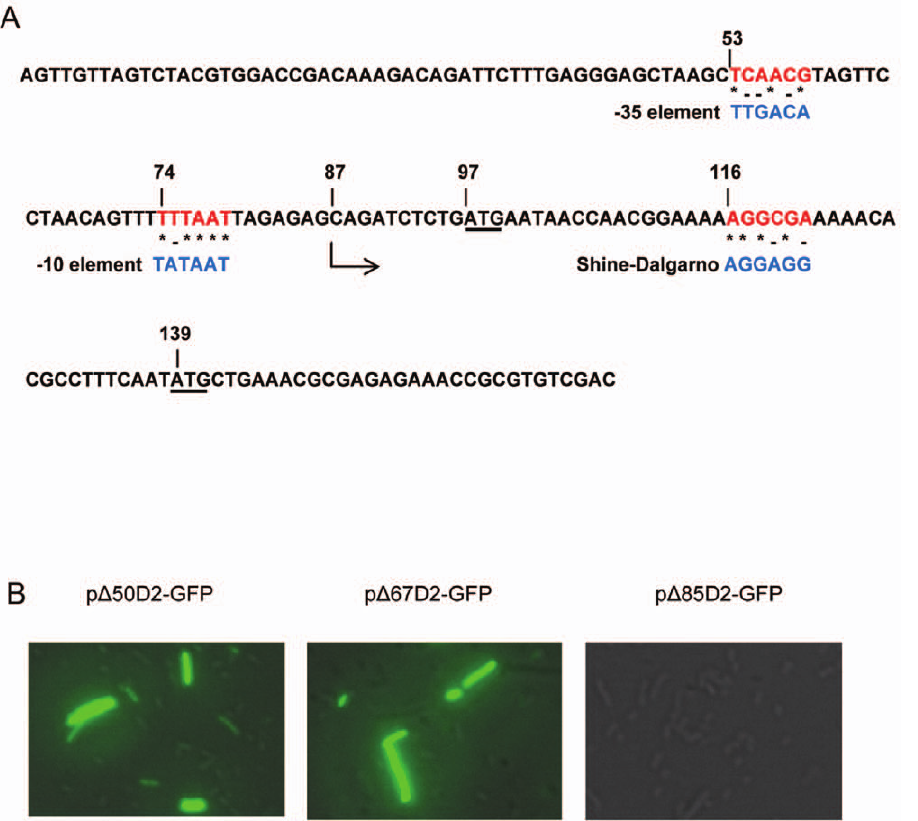
Figure 2. Cryptic promoter sequence analysis. (A) The cDNA sequence encoding the 5 9 terminal 170 nt of the DENV2 RNA genome. The putative 2 10 and 2 35 cryptic promoter elements and the putative Shine-Dalgarno sequences (red) are aligned with their corresponding E. coli wild type elements (blue). The cDNA encoding the authentic DENV2 start codon (97AUG) and the in-frame alternate start codon (139AUG) are underlined. The predicted transcription initiation site is at the cDNA encoding DENV2 nt 87. (B) Fluorescent microscopy images of E. coli cells transformed with deletion mutant plasmids that result in truncations of 50 nt, 67 nt and 85 nt from the 5 9 end of DENV2 RNA, respectively.